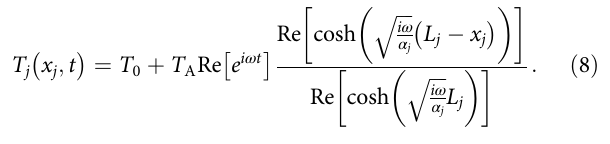
observe is 786 μ W for the Cu/G/OD resonator. This value can be compared with previous efforts to harvest from temperature fl uctuations using non-PCMs 23 – 27 and unmodi fi ed PCMs 30,31